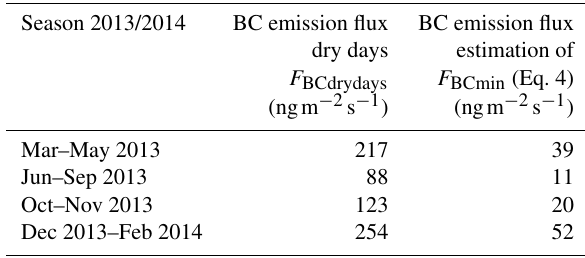
Table 3. Estimated BC emission fluxes for four seasons for dry days F BCdrydays and F BCmin as estimated in Eq.